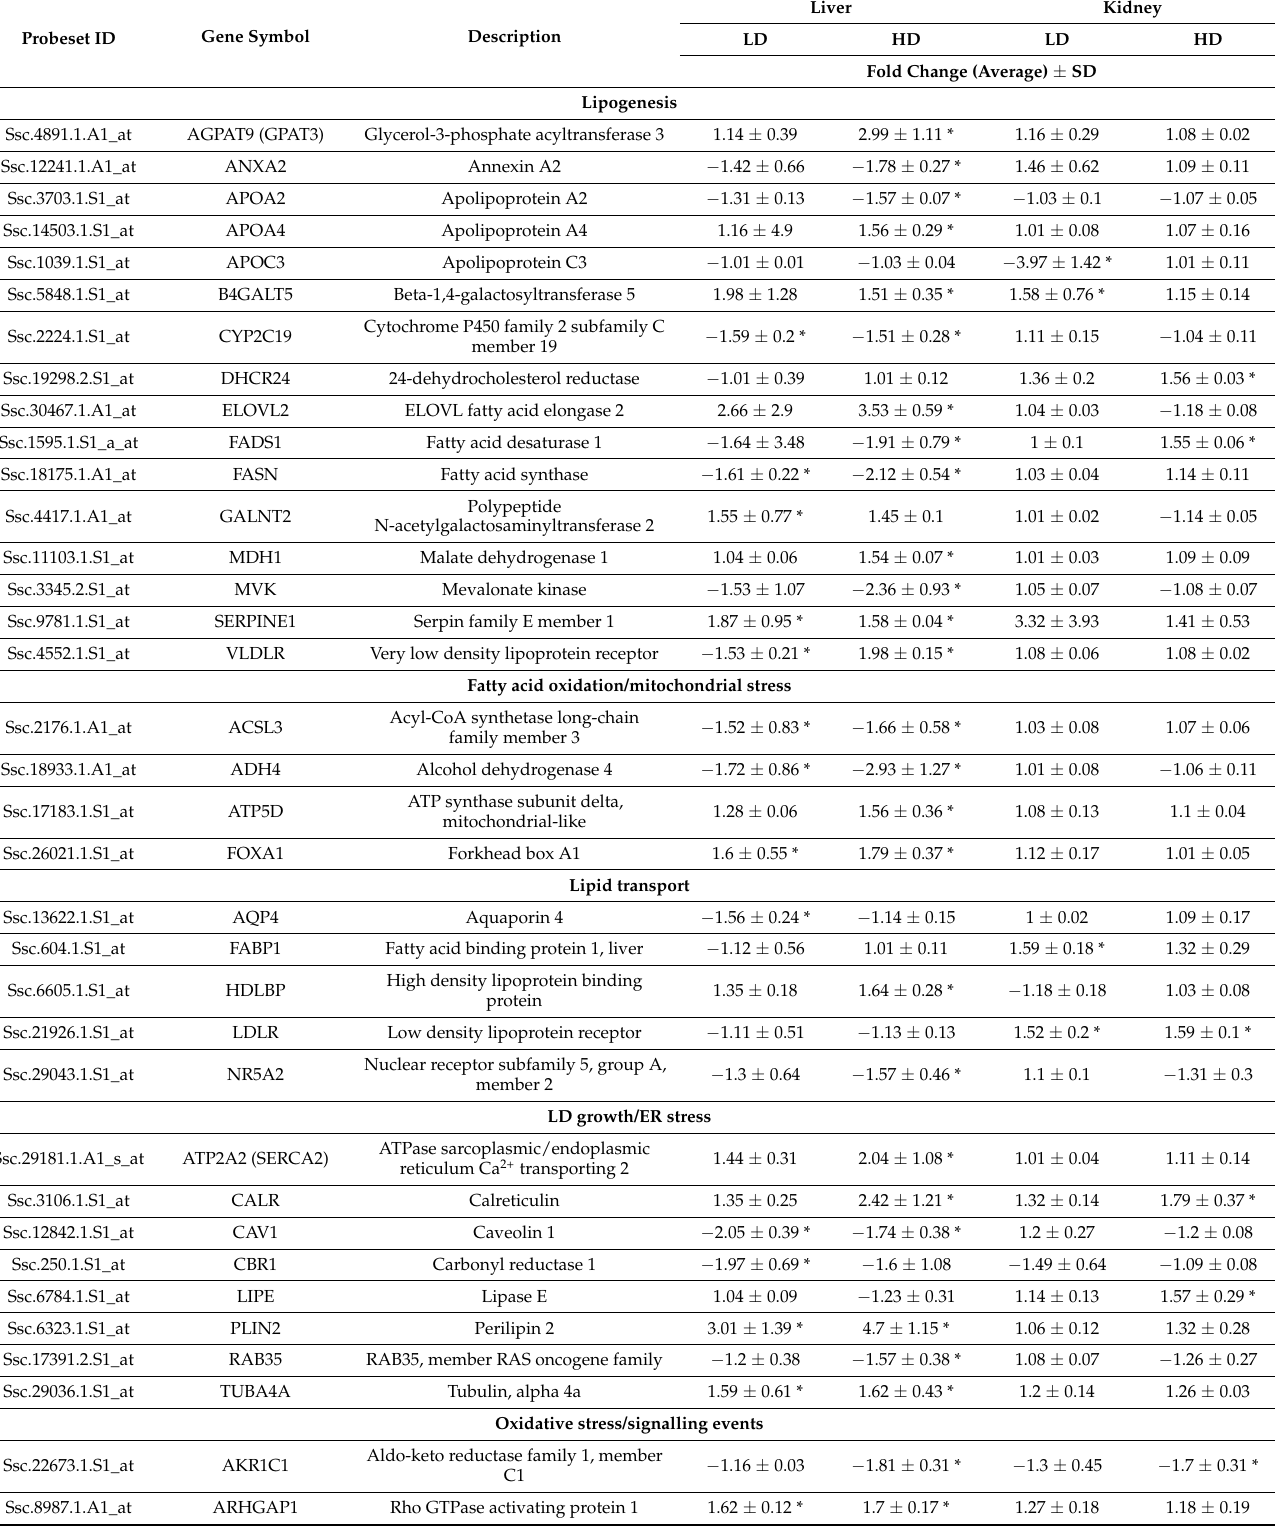
Table 6. Drug-induced steatosis-regulated genes in the liver and kidney. Based on mechanistically linked and lipid-droplet-associated gene regulations, a total of 65 DEGs were identified after di- clofenac treatment and categorized based on their biological processes. * Differentially expressed genes (Foldchange > ± 1.5, p -value < 0.05 and FDR <